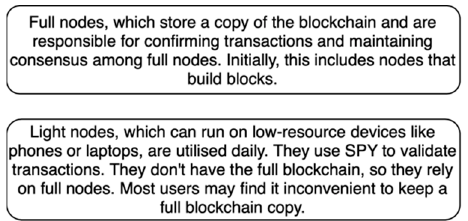
Figure 6. Types of Nodes.